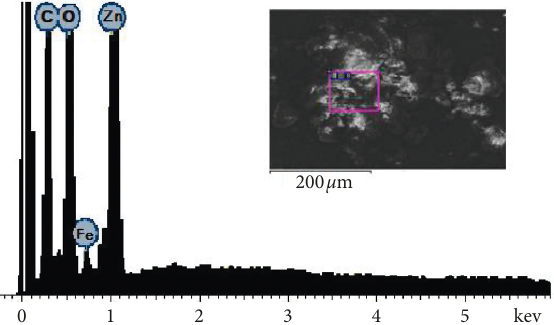
Figure 4: X-MaxN energy spectrum of Fe(II)/MOF-5 (3% Fe 2+ ).